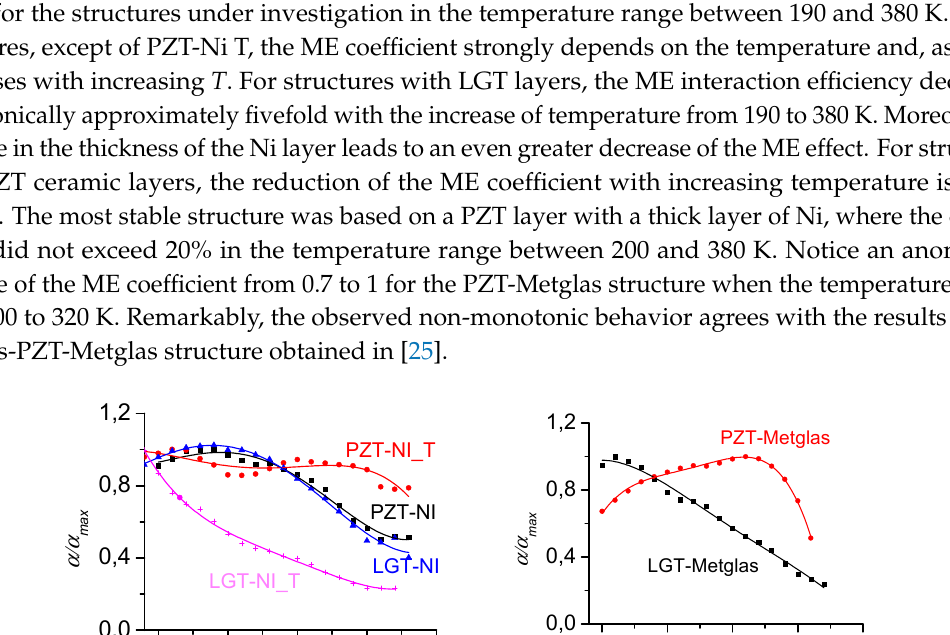
Figure 12. Dependences of quality factor Q on temperature. The values for the LGT-Ni structure are scaled down by a factor of 10.